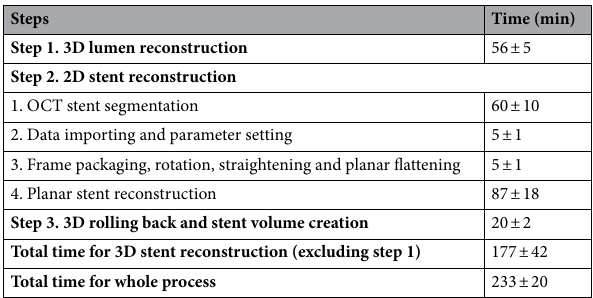
Table 4. Processing times for 3D stent reconstruction in clinical cases (n =